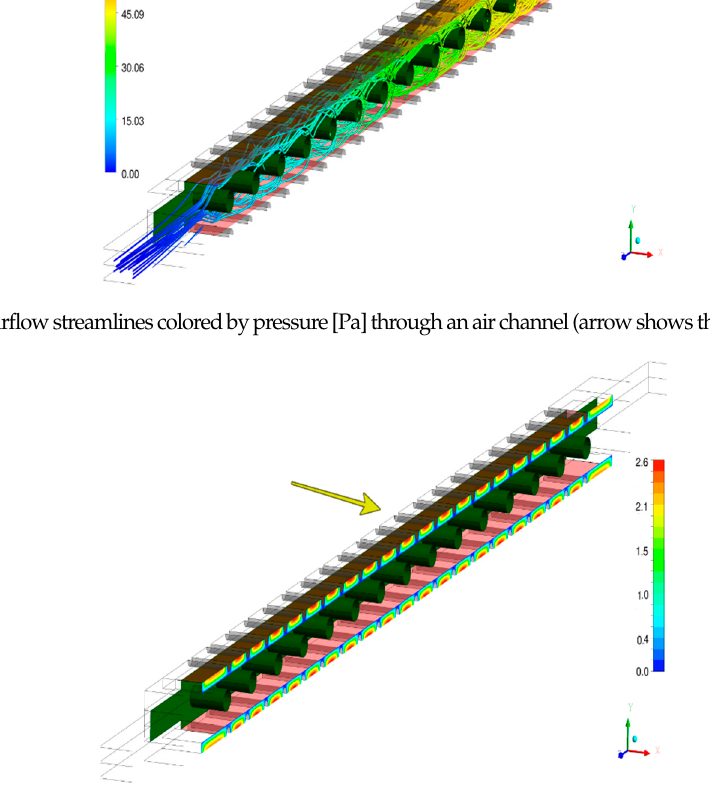
Figure 5. Velocity [mm / s] contours in the desiccant channel (arrow shows the desiccant flow direction). Figure 5. Velocity [mm/s] contours in the desiccant channel (arrow shows the desiccant flow direction). Figure 5. Velocity [mm/s] contours in the desiccant channel (arrow shows the desiccant flow direction). Figure 5. Velocity [mm/s] contours in the desiccant channel (arrow shows the desiccant flow direction).